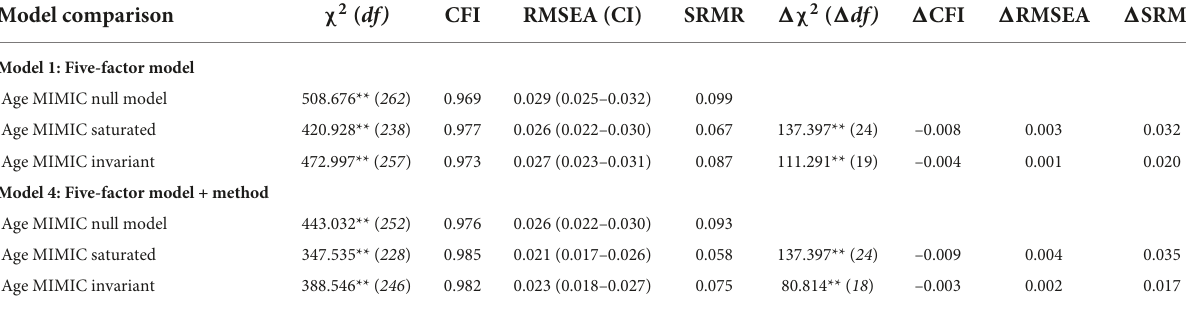
Models1and4havethefollowingmodifications:omitteditem13andaddedcorrelationsforitemswithinthesamefactors(i.e.,item2withitem10,item23withitem6;item9withitem 20,item24withitem16).CFI,comparativefitindex;RMSEA,rootmeansquareerrorofapproximation;SRMR,standardizedrootmeansquareresidual.** p <